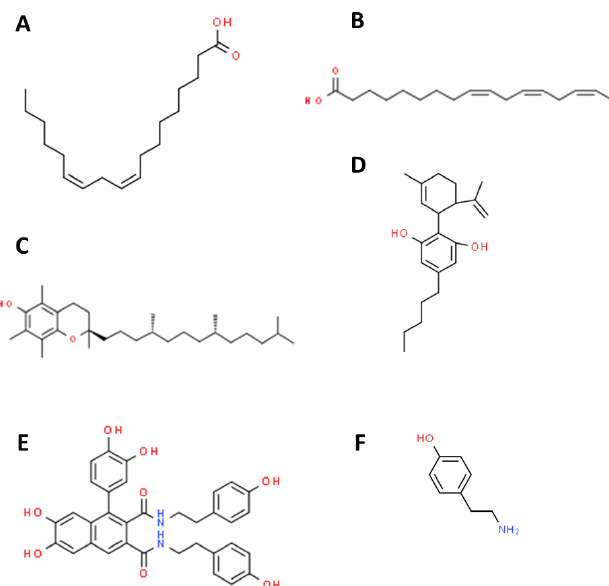
Figure 2. Chemical structures of selected biologically active compounds of industrial hemp. ( A ) Linoleic acid (omega-6 polyunsaturated fatty acid [PUFA]), ( B ) alpha-Linolenic acid (omega-3 PUFA), ( C ) Tocopherol, ( D ) Cannabidiol (CBD), ( E ) Cannabisin A, and ( F ) Caffeoyltyramine.